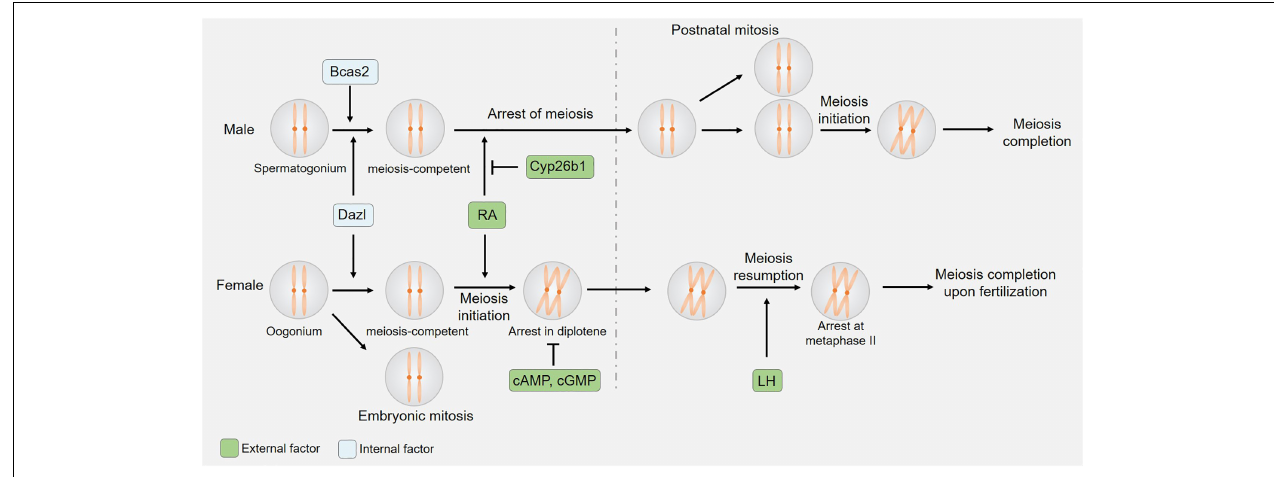
FIGURE 1 | Sexual dimorphism in the initiation and kinetics of meiosis. Both germ cell-derived internal factors and somatic cell-derived external factors regulate meiotic initiation. The expression of CYP26B1 by somatic cells of the embryonic testis suppresses RA-induced meiotic entry, while cAMP/cGMP and LH control oocyte-specific meiotic arrest and